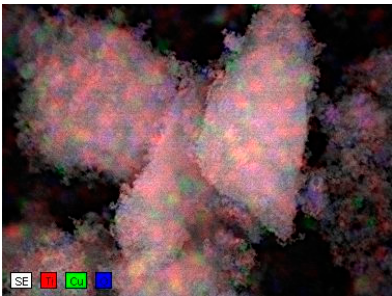
Table 1. The theoretical and real content of Cu in the composites, and the band gap energies and the degradation efficiencies (for methyl orange and ketoprofen) of the composites. EDX = energy- dispersive X-ray spectroscopy.